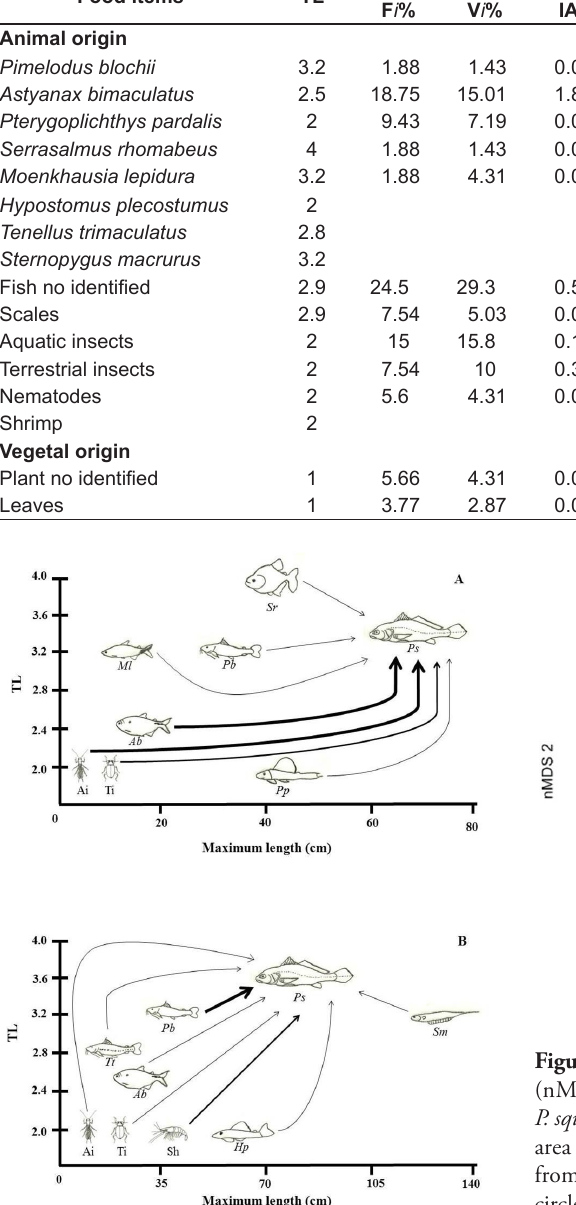
Figure 3. Simplified food chain for Plagioscium squamosissimus ( Ps ) in preserved area (A) and impacted area (B) in Machado River (Brazil). Arrow width illustrates importance in the diet Y-axis = trophic level (TL), X-axis: maximum length (cm). (TL and maximum length are from Froese & Pauly, 2019 and or literature).